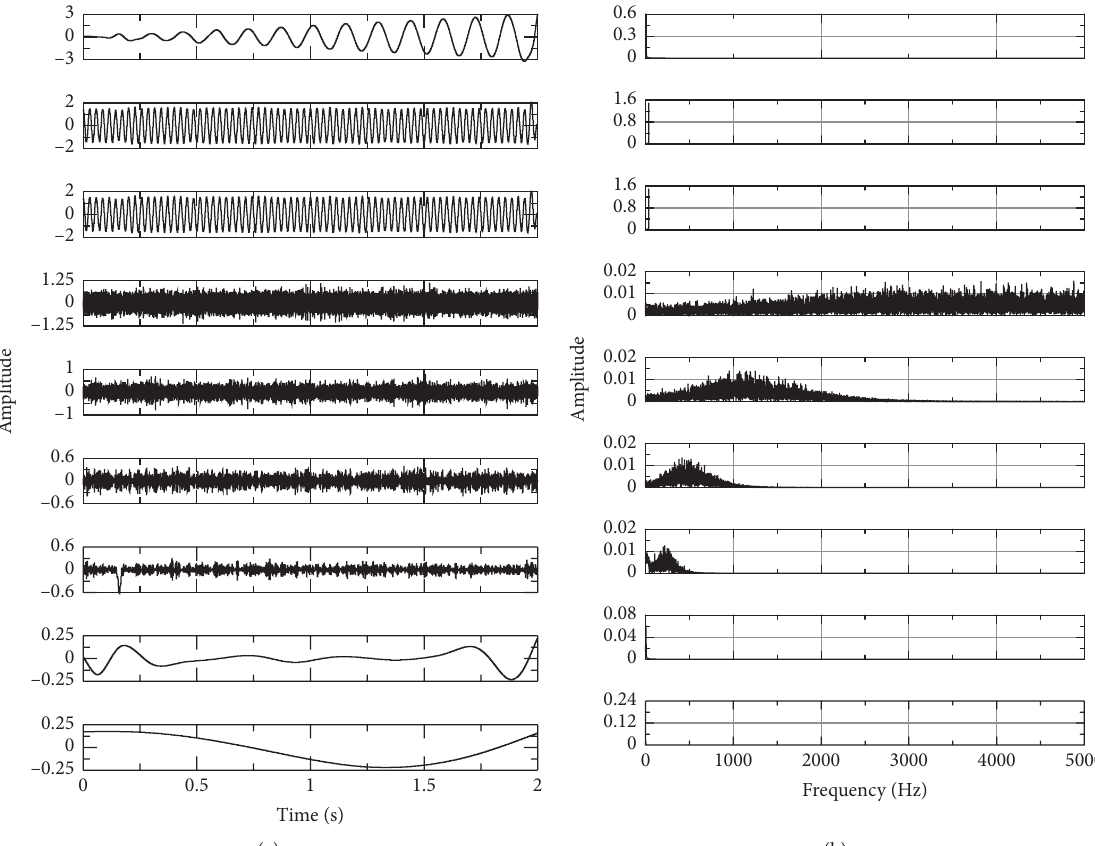
Figure 4: The synthetic signal is decomposed by EEMD. (a) Time domain. (b) Frequency domain.